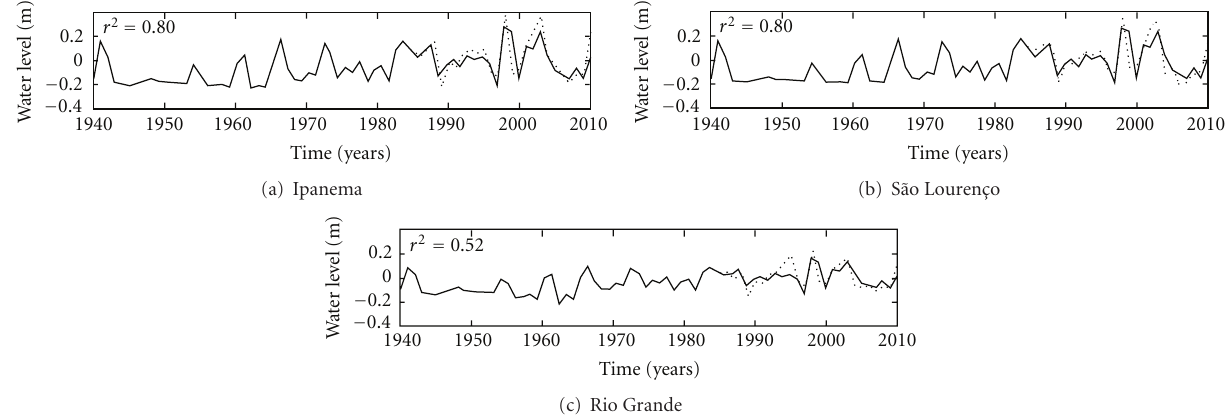
Figure 4: Water levels series calculated between 1940 and 2010 (solid line) and observed water levels series between 1985 and 2010 (dotted line) in Ipanema (a), S˜ao Lourenc¸o (b), and Rio Grande (c). Coe ffi cients of determination ( r 2 ) are presented in the figures.